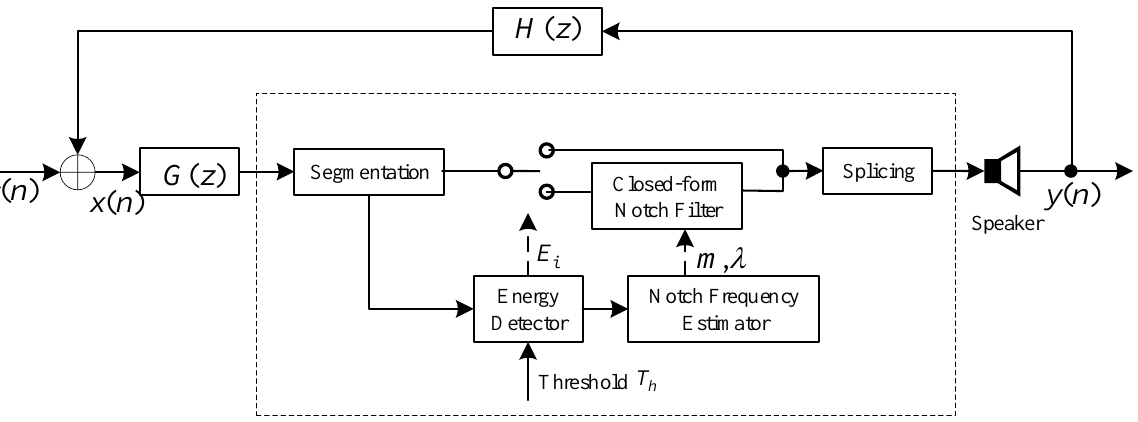
Figure 3. The hearing aid model diagram with howling detection and a notch